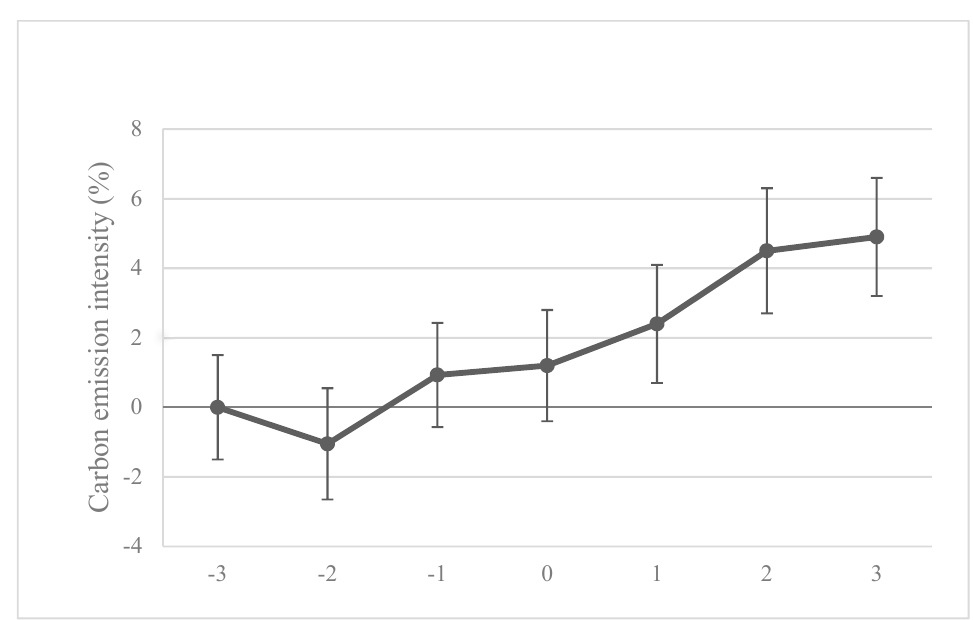
Figure 2. Testing parallel trend. Table 3. Placebo robustness